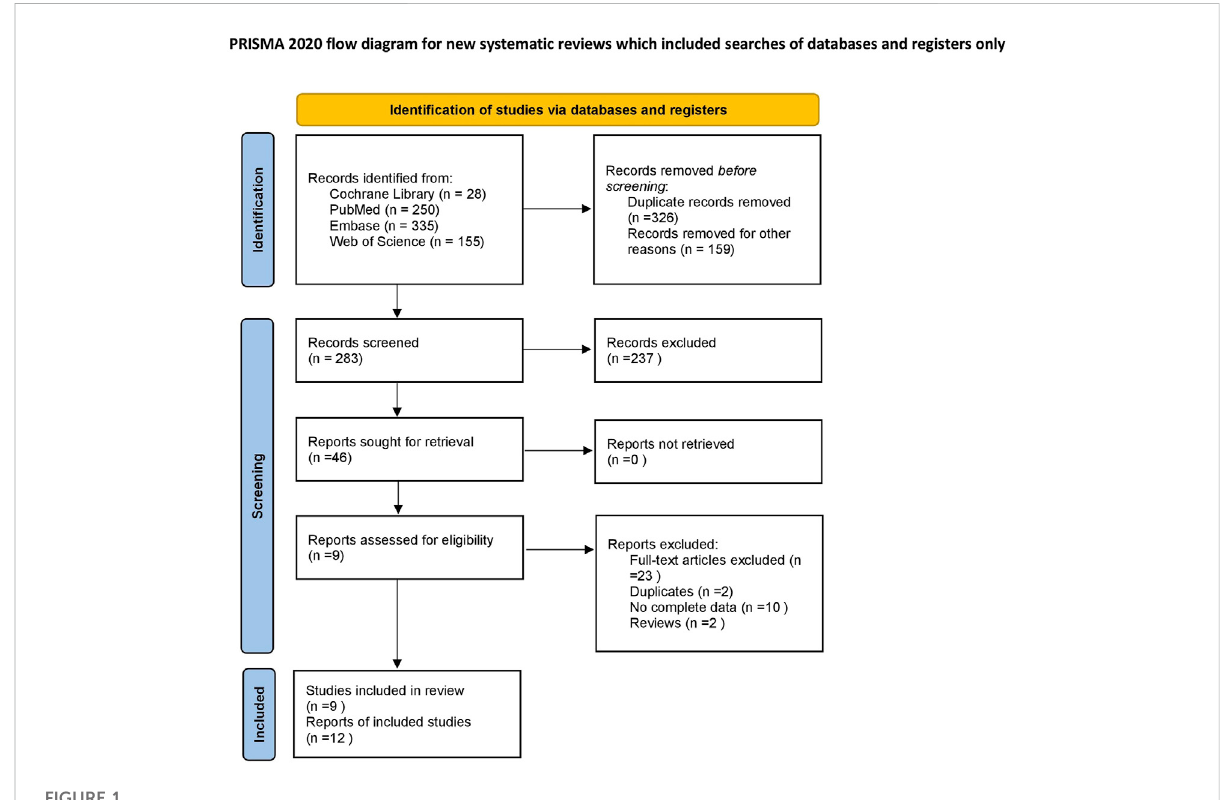
FIGURE 1 Flow chart of literature